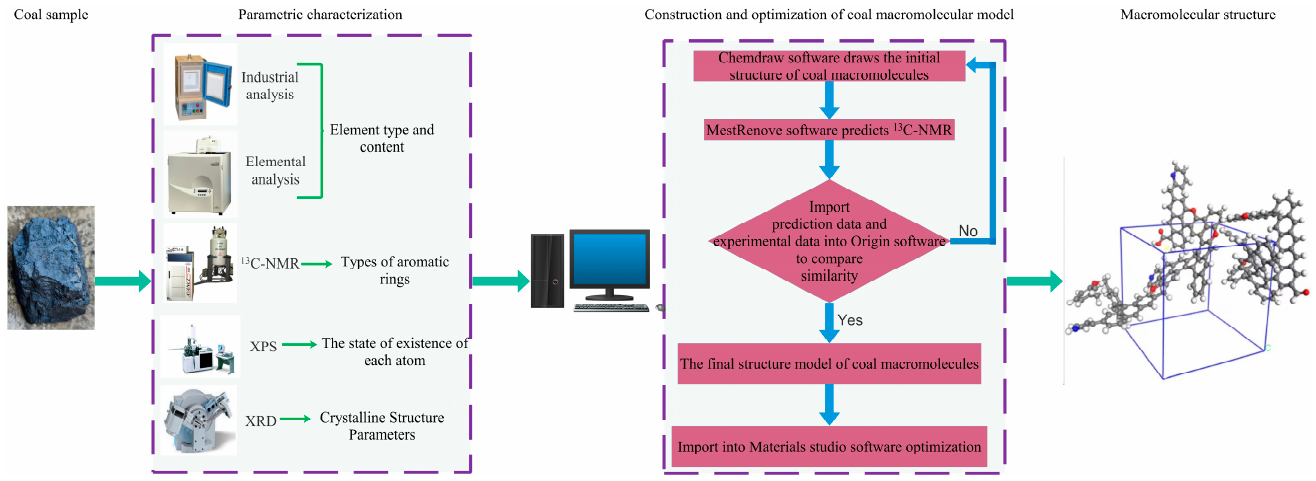
Figure 1. Gas coal macromolecular modeling flow